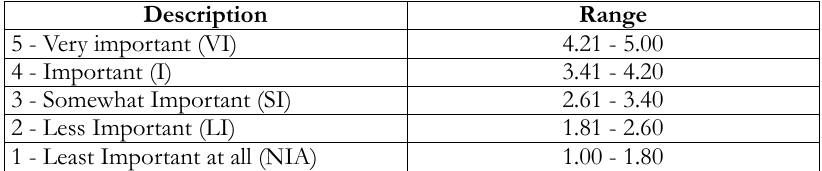
Table 1. Interpretation of the Results of the Importance of a Soft and Hard